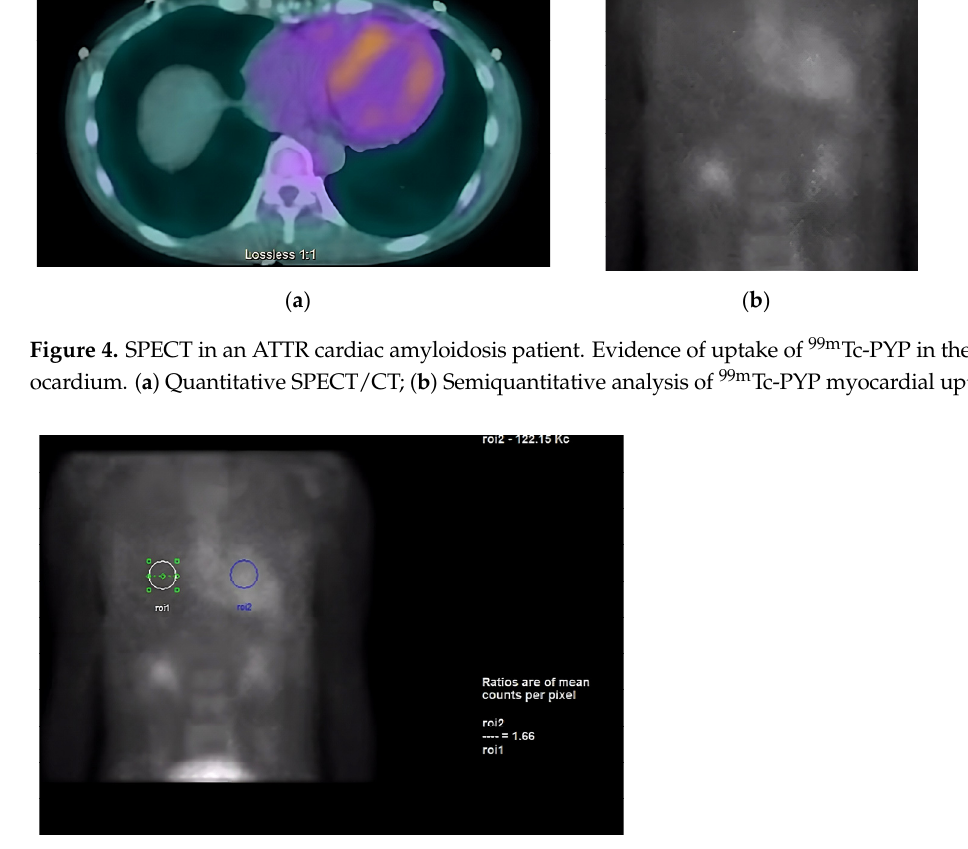
Figure 5. Heart-to-contralateral ratio was calculated by drawing a region of interest over the heart, mirroring it to the contralateral chest, and calculating the ratio of heart ROI to contralateral chest ROI mean counts. The representative image demonstrates a H/CL ratio of 1.6. (H/CL, heart-to-contralateral; ROI, region of interest).